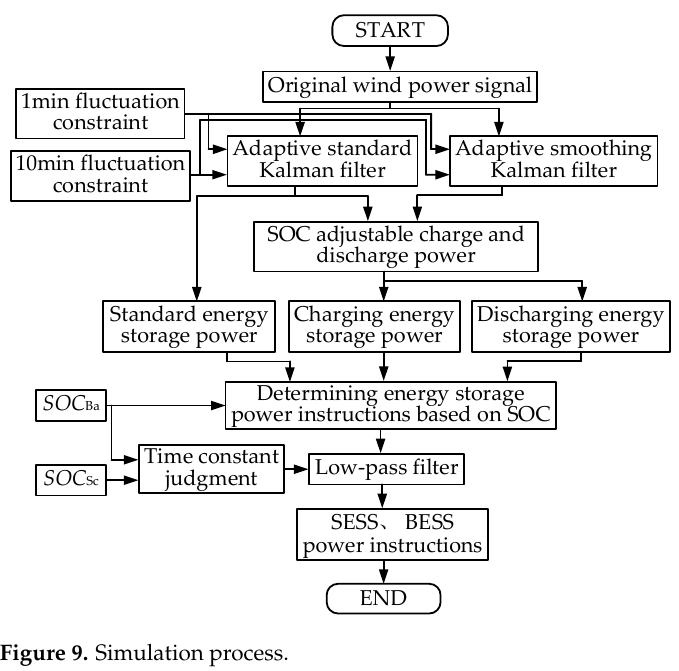
Figure 9. Simulation process.